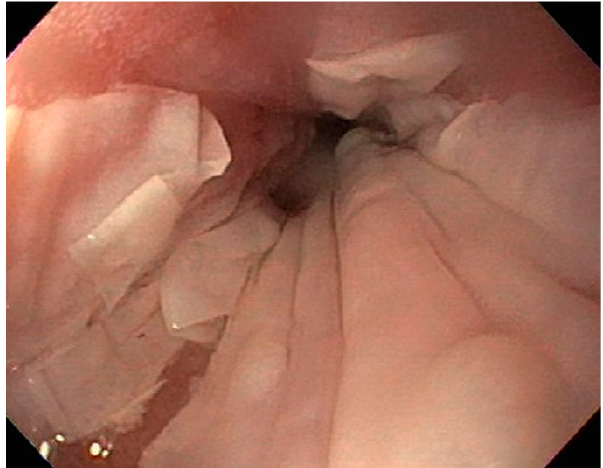
Figure 8. Sloughing in mid esophagus noted on endoscopy.